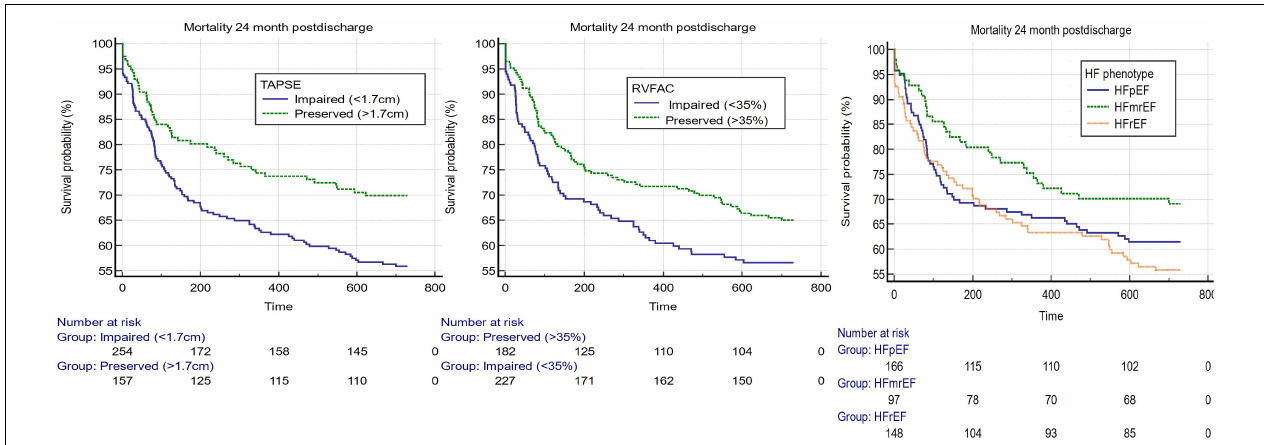
FIGURE 1 | Kaplan–Meier estimates 3 guideline-suggested cutoffs of the most used systolic assessments of both the right and left ventricles. From left to right, TAPSE (cutoff 1.7 cm) ( p -value = 0.0051), RV FAC (cutoff 35%) ( p -value = 0.049), and LVEF (cutoffs for heart failure with preserved ejection fraction (LVEF > 50%), heart failure with mildly reduced ejection fraction (LVEF 41–49%) and heart failure with reduced ejection fraction (LVEF < 40%) ( p -value = 0.109).